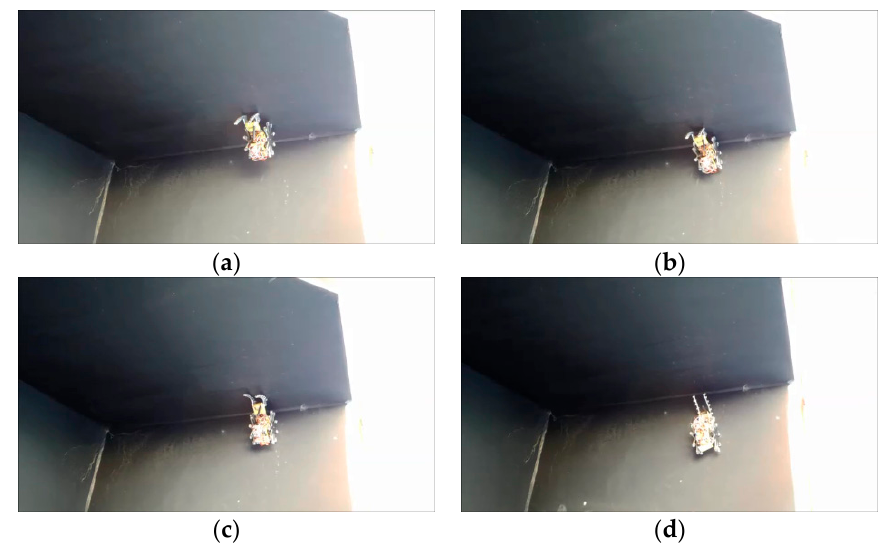
Figure 11. BIREM 3rd moving along route 1. ( a ) 0 s; ( b ) 5 s; ( c ) 10 s; ( d ) 15 s.